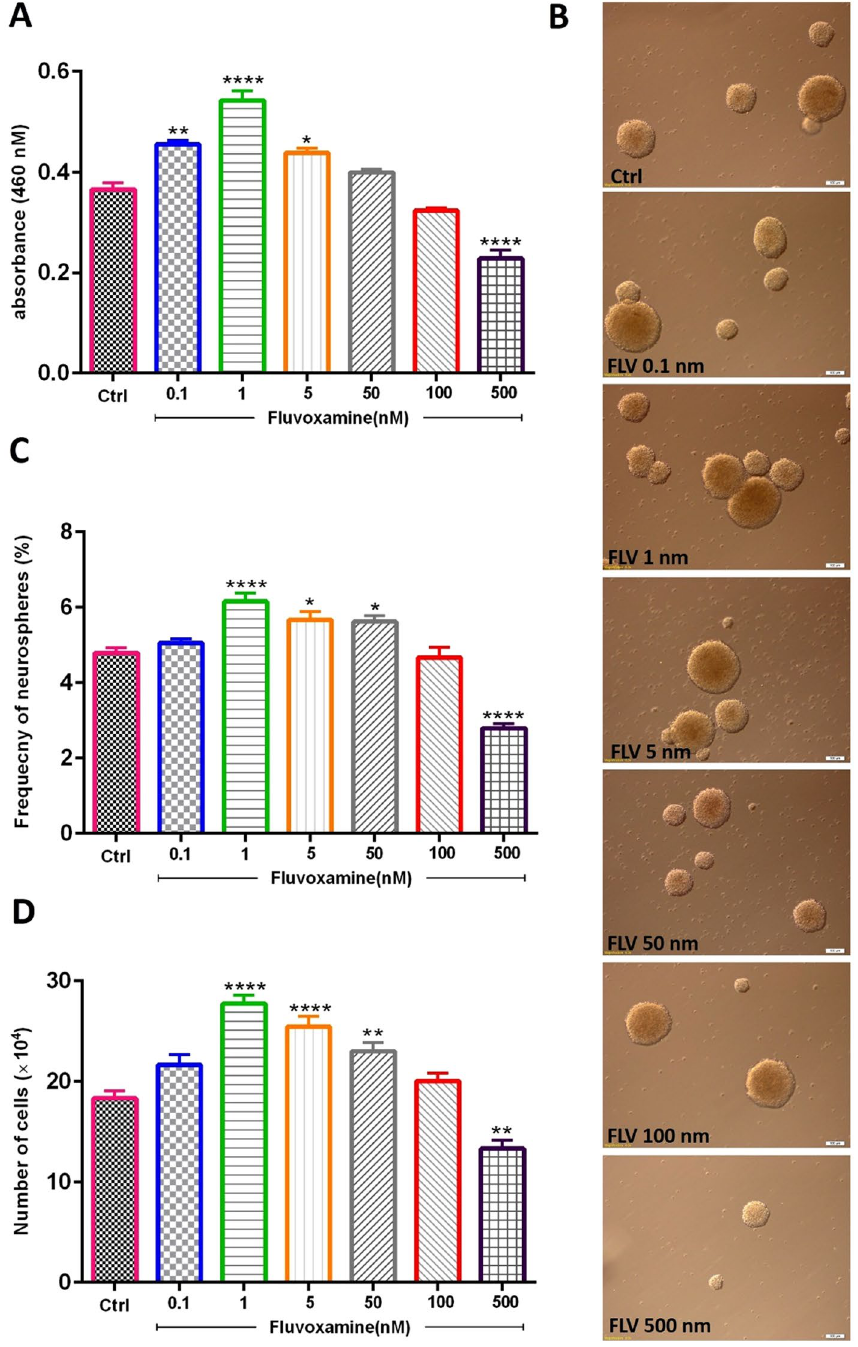
Figure 1. Effect of fluvoxamine on NSC viability and neurosphere formation in vitro . ( A ) The number of viable cells was evaluated using MTT assay. Fluvoxamine increased the number of viable cells as compared to the control group. Each bar represents the mean value of absorbance at 460 nm. ( B ) Representative images of neurospheres in the different groups. Scale bar = 100 μ m ( C ) Fluvoxamine significantly increased neurosphere formation at 1, 5, and 50 nM, while it was toxic at 500 nM. ( D ) Cell counts obtained from neurospheres showed an increase of the mean cell number at 1, 5 and 50 nM. Data were expressed as mean ± SEM and each experiment included 15 replicates per condition (n =